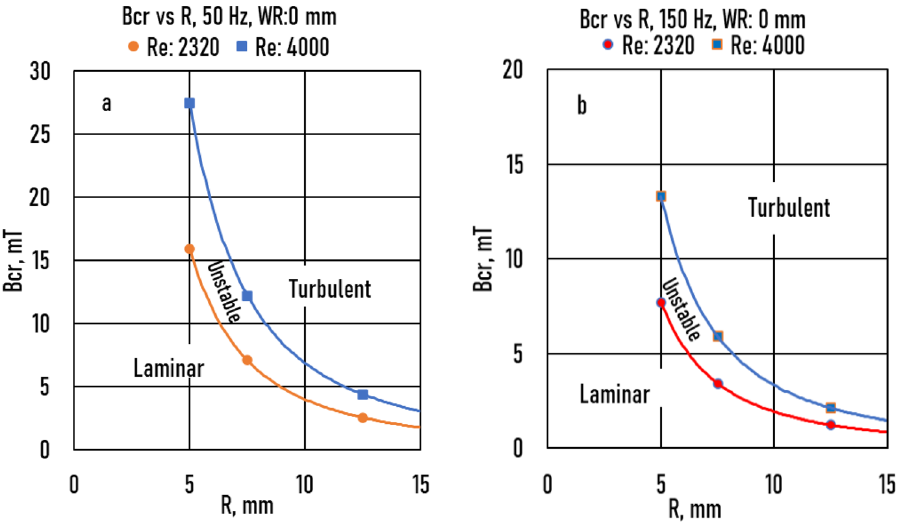
Figure 13. The critical magnetic induction ( Bcr ) as a function of sample radius ( R ) ( a ): f = 50 Hz, ( b ): f = 150 Hz at WR =